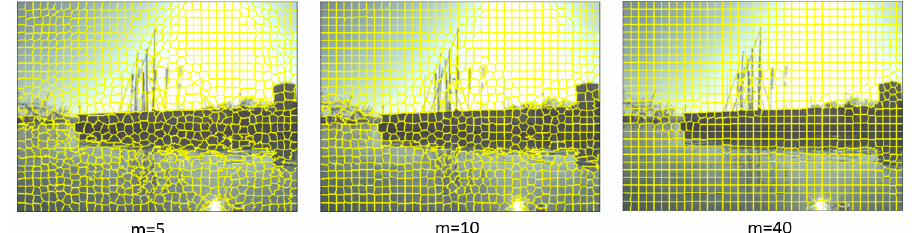
Figure 4. Different values of m lead to different segmentation results for the SLIC algorithm. m = 5,10,40 were presented.